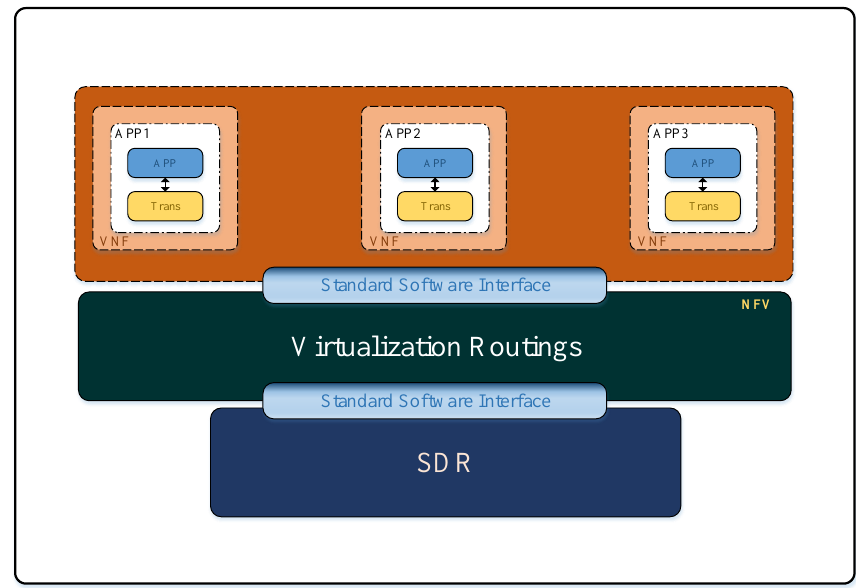
Figure 6. Implement of MMNET multi-application organization.